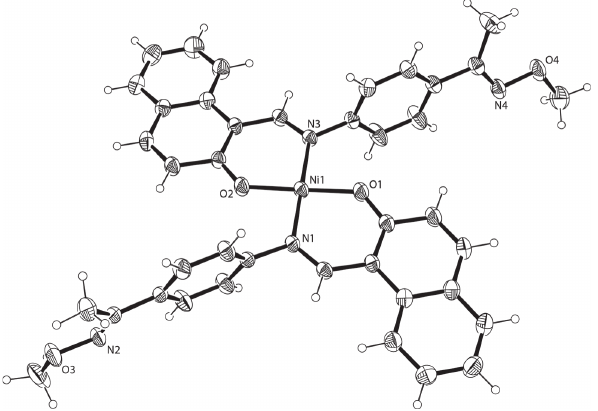
Table 2: Fractional atomic coordinates and isotropic or equivalent isotropic displacement parameters (Å 2